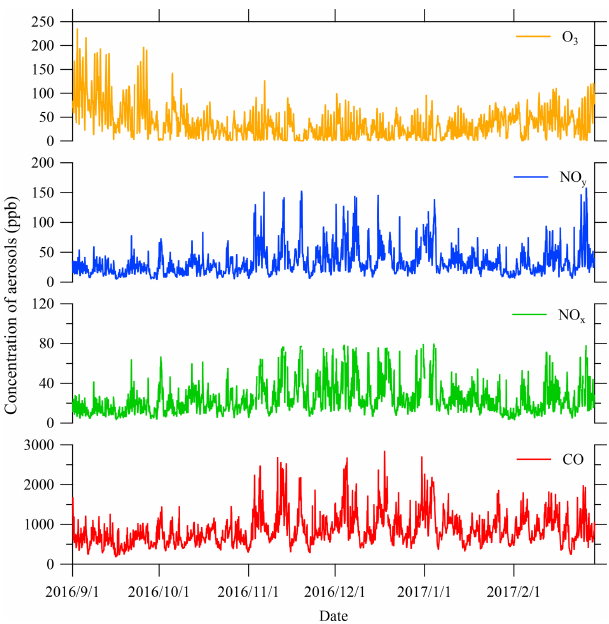
Figure 4. Time series of O 3 , NO y , NO x , and CO concentrations at the Gulou site from September 2016 to February 2017.